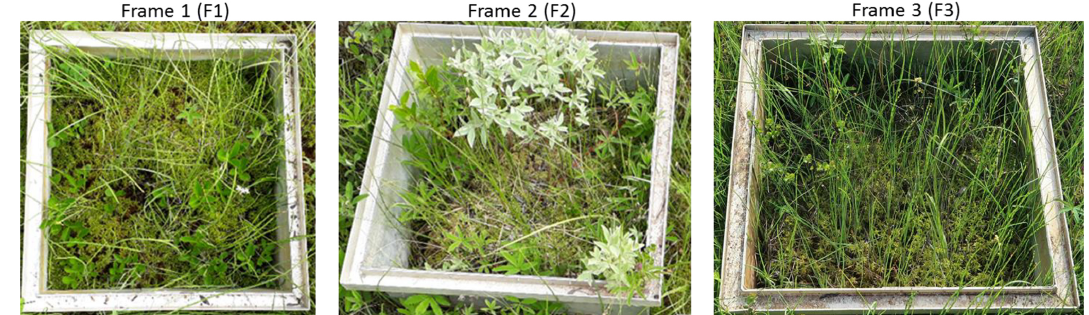
Figure 1. Vegetation cover of the measured frames at the beginning of July in